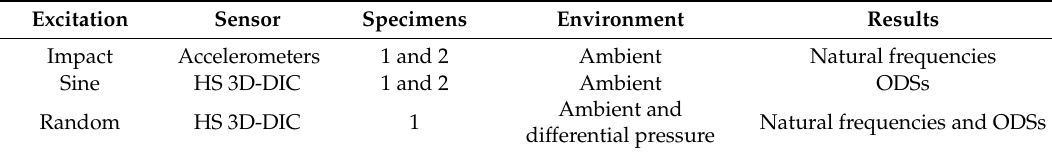
Table 1. Summary of the test configurations.